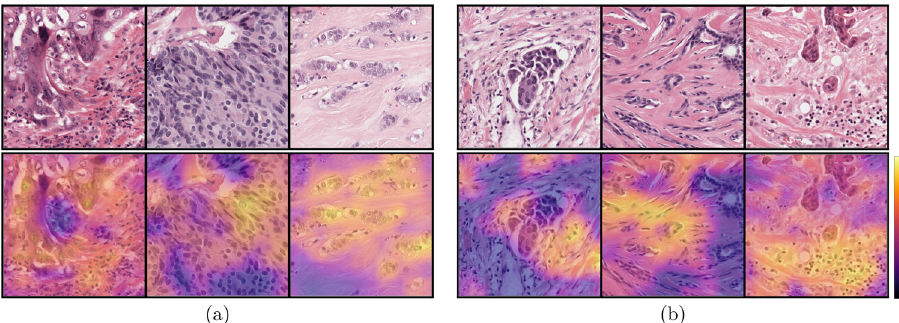
Fig. 3 Grad-CAM saliency outputs of six patches from the evaluation set in the ROI-study. The predictions were close to the reference scores ( a ) when the AI algorithm focused on the cellular structures and it failed in few cases ( b ) focusing on other tissue parts.